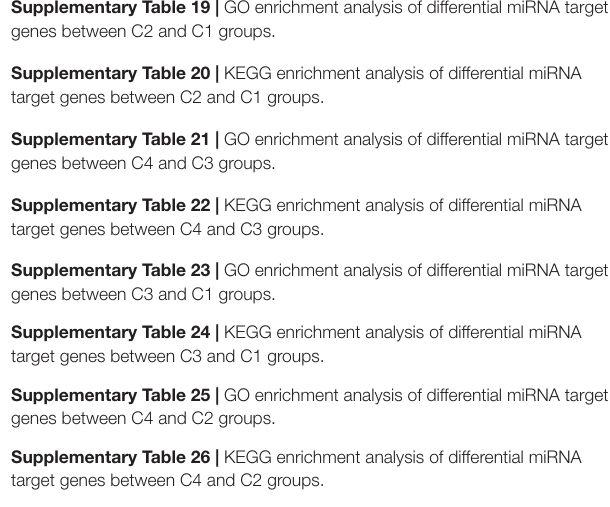
Supplementary Table 16 | COG classification statistics of differentially expressed genes between C3 and C1 groups. Supplementary Table 17 | COG classification statistics of differentially expressed genes between C4 and C2 groups. Supplementary Table 18 | Number of common differential miRNAs. Supplementary Table 19 | GO enrichment analysis of differential miRNA target genes between C2 and C1